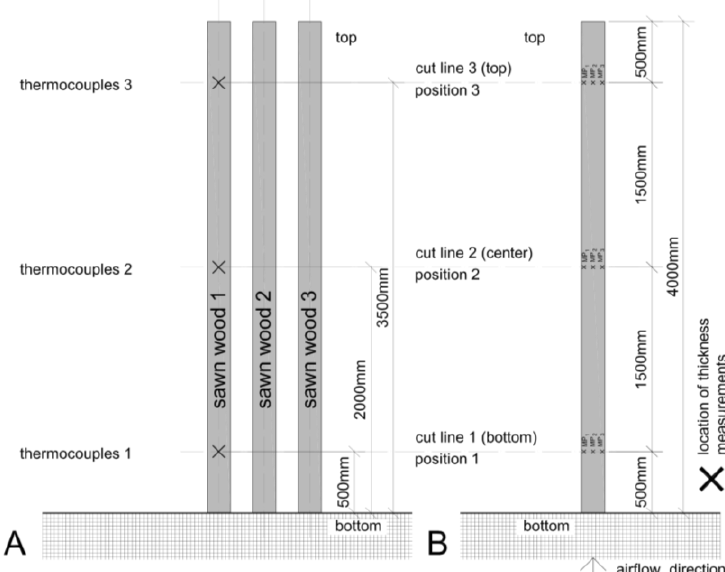
Figure 2. Position of thermocouples at different heights ( A ), cut lines for charred layer thickness (measurement points MP 1 , MP 2 , and MP 3 ), and cupping effect measurements ( B ).